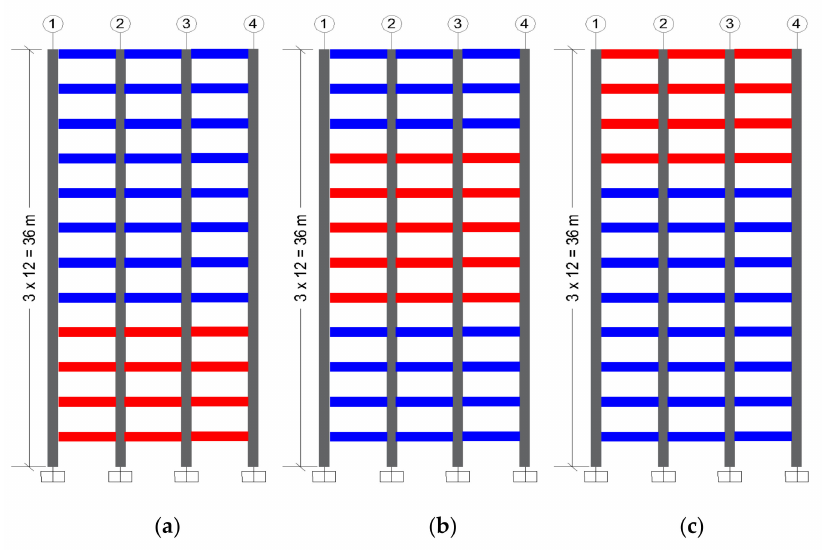
Figure 3. Building models with mass irregularity: ( a ) bottom mass (BM); ( b ) middle mass (MM); ( c ) top mass